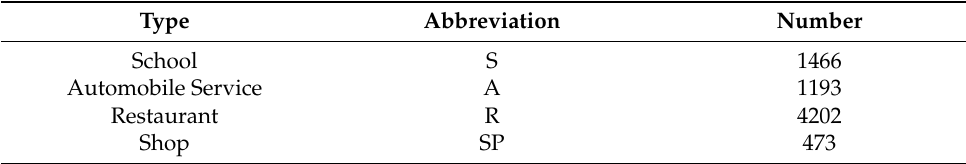
Table 3. In the real data, the number and category of 4 kinds of